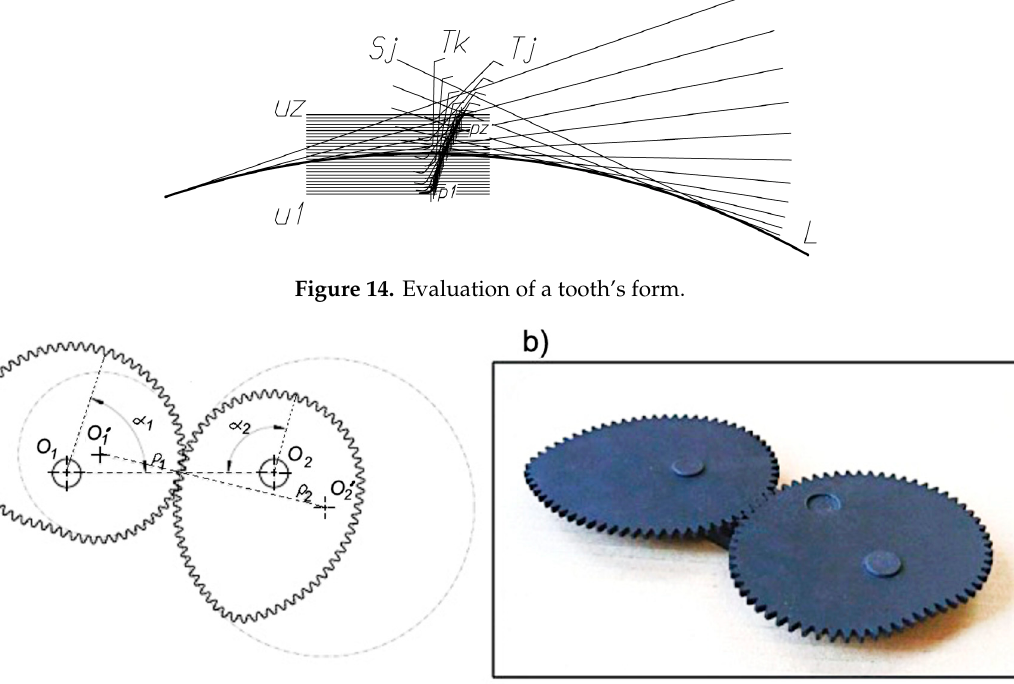
Figure 15. ( a ) Model of a non-circular gear; ( b ) machined gear.